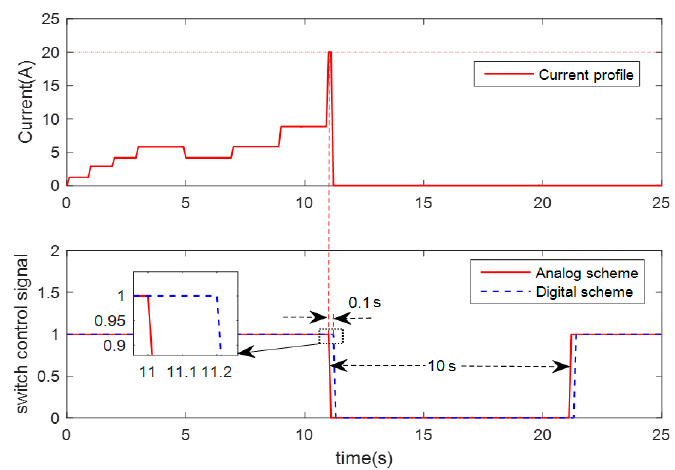
Figure 15. External short-circuit fault detection and self-recovery curve.